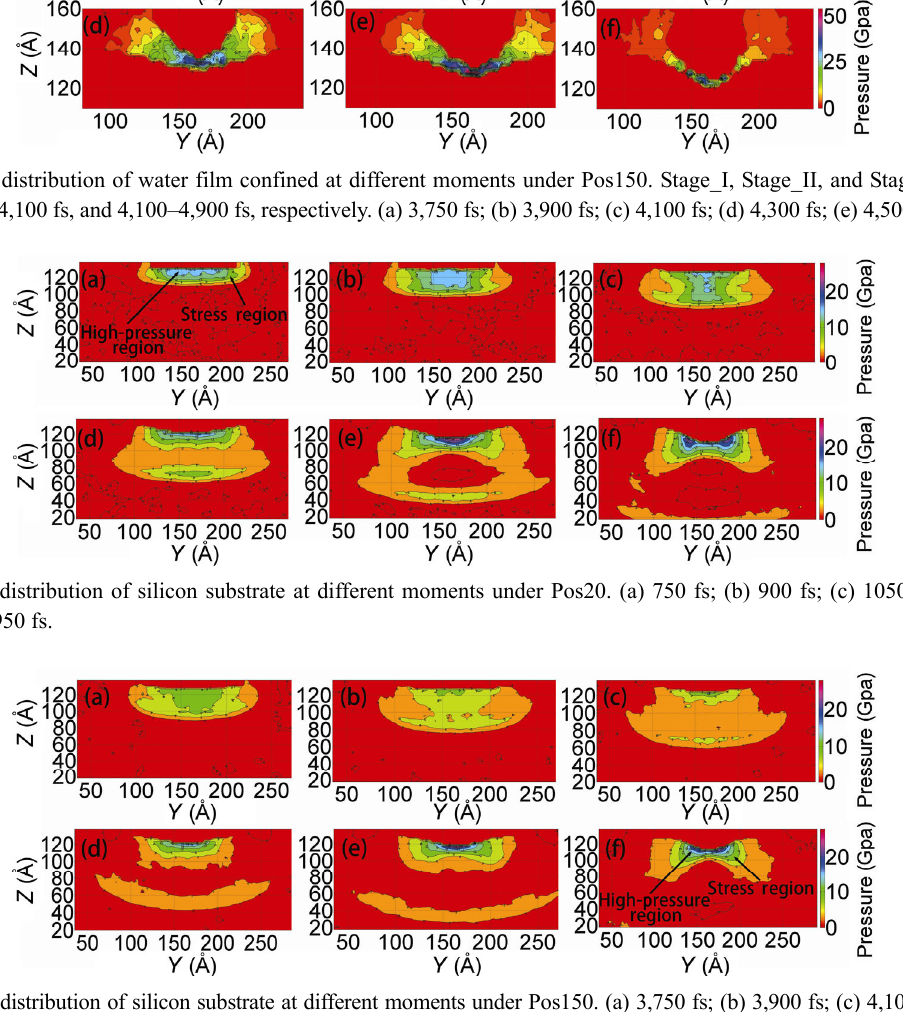
Fig. 13 Pressure distribution of silicon substrate at different moments under Pos150. (a) 3,750 fs; (b) 3,900 fs; (c) 4,100 fs; (d) 4,300 fs; (e) 4,500 fs; (f) 4,900